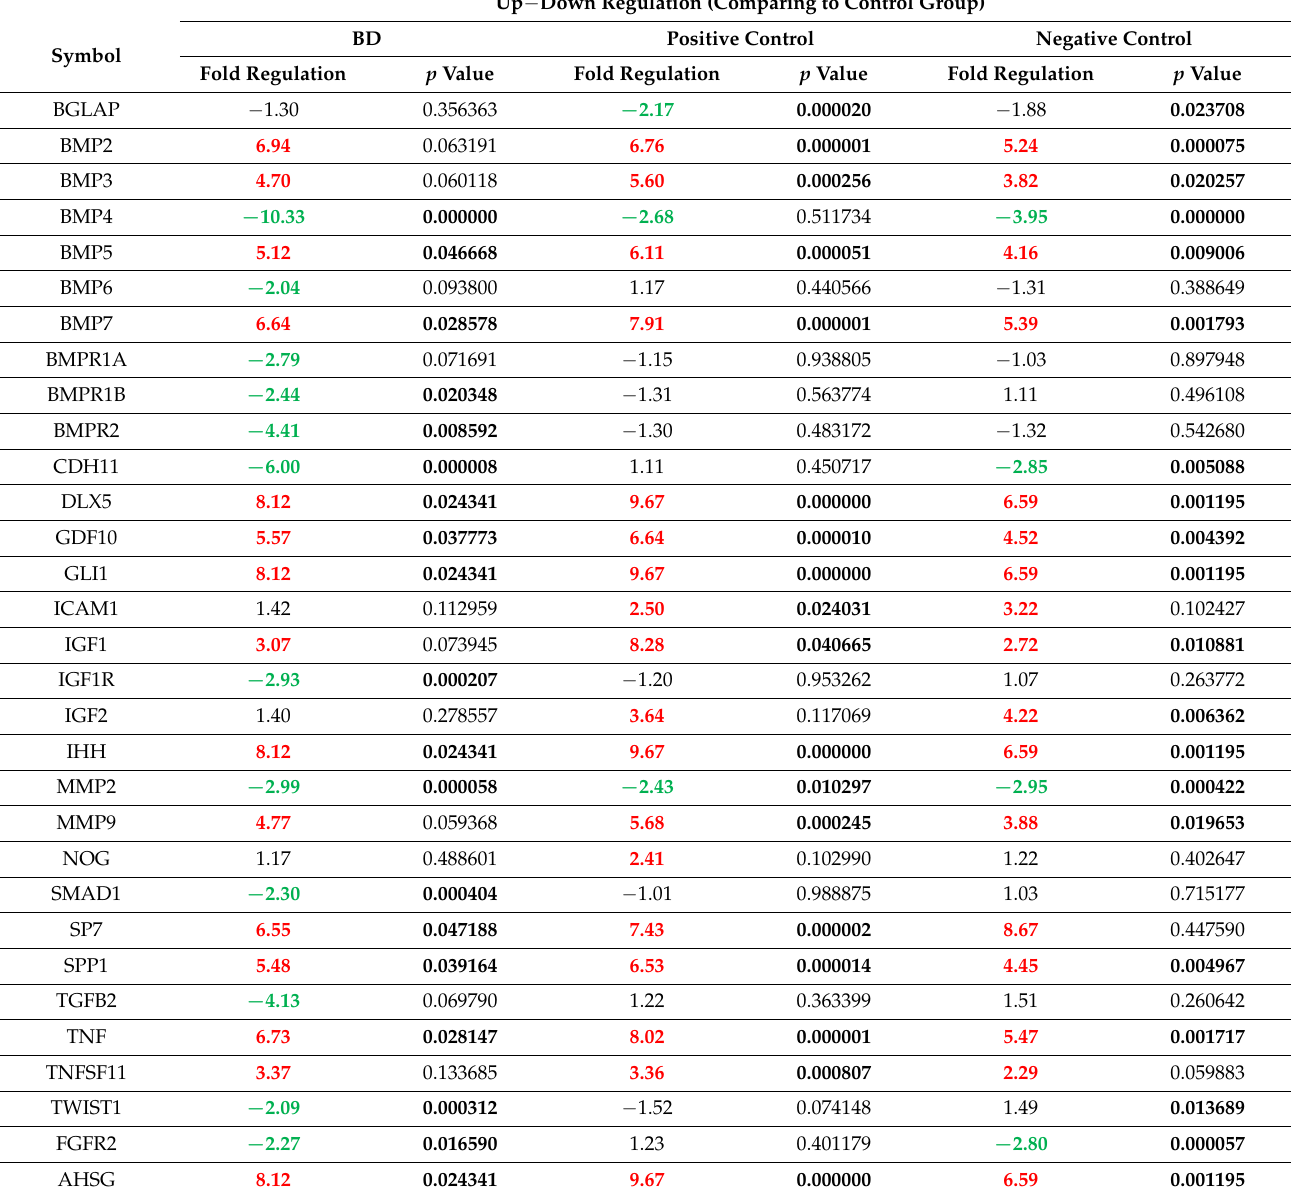
Table 1. PCR array results of fold changes and the statistical significance of genes that are involved in odontogenic differentiation and ossification. All groups were compared to day 1 of treatment. Red: upregulated genes, Green: Downregulated genes. The bold numbers represent significant p